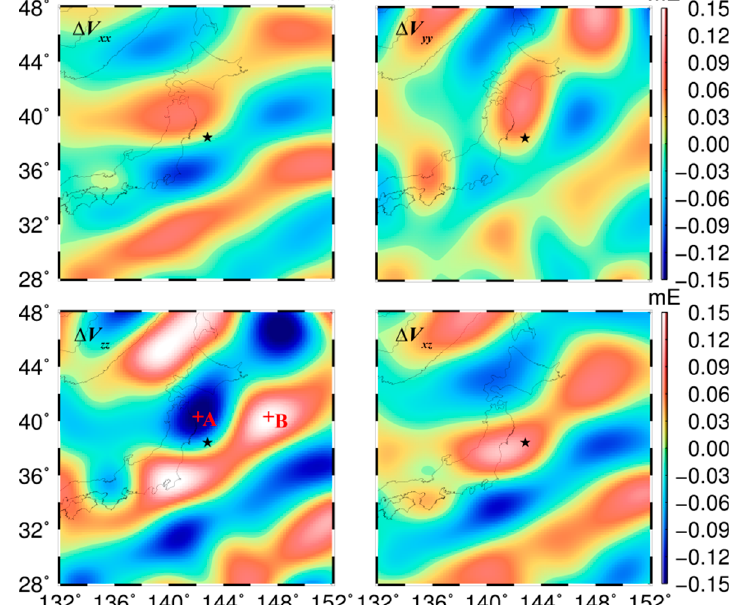
Figure 12. Gravity gradient changes ( Δ V xx , Δ V yy , Δ V zz , and Δ V xz ) in Local North-Oriented Frame on a sphere with a height of 260 km computed by the tailored spherical harmonic coefficients from the GOCE observations with a Gaussian filter applied. The SH degree range is 30–95, and the radius of the filter is 210 km. The units are mE.